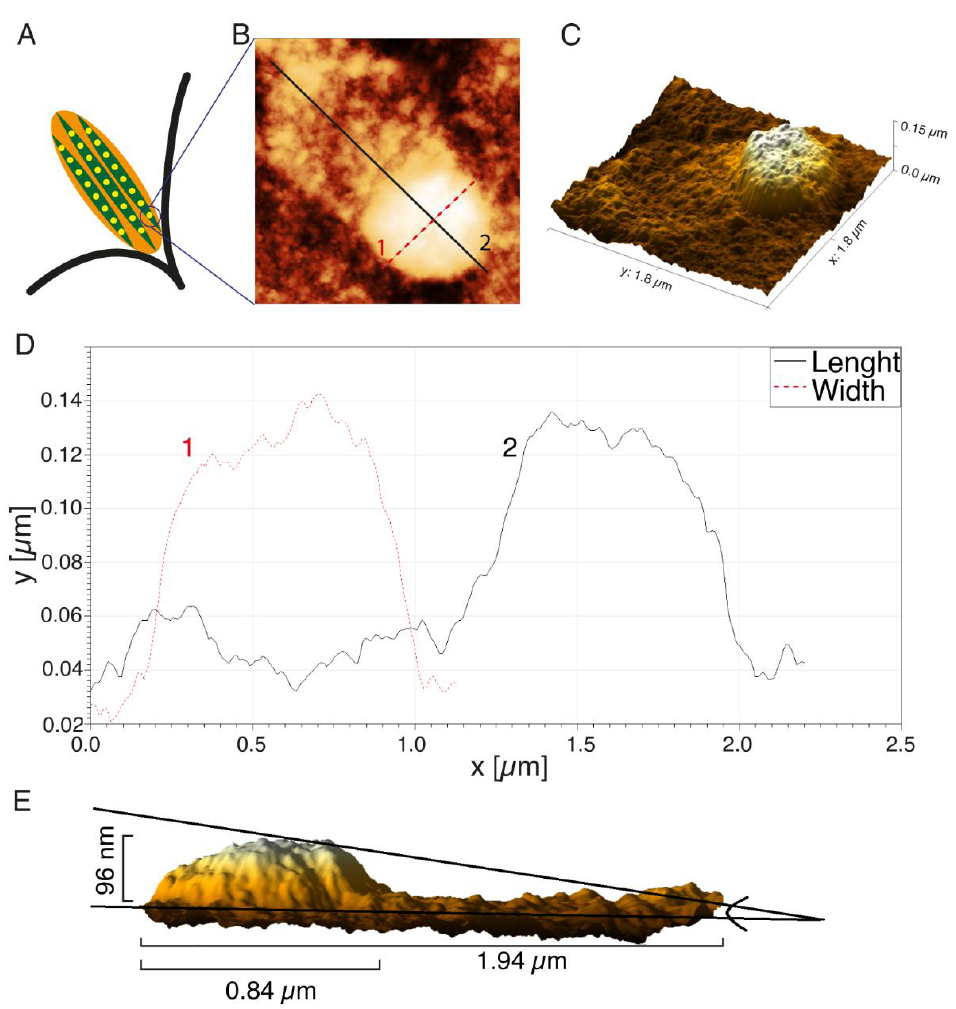
Figure 4. Analysis of topography of the single FA imprints. ( A ) Scheme of the FA structure; ( B ) the AFM image of the FA; ( C ) the 3D reconstruction; ( D ) the height distribution of the FA imprints; ( E ) a side view of the FA reconstruction. AFM images were processed using Gwyddion 2.53 software. Reproduced with permission from Osuchowska et al. [9].